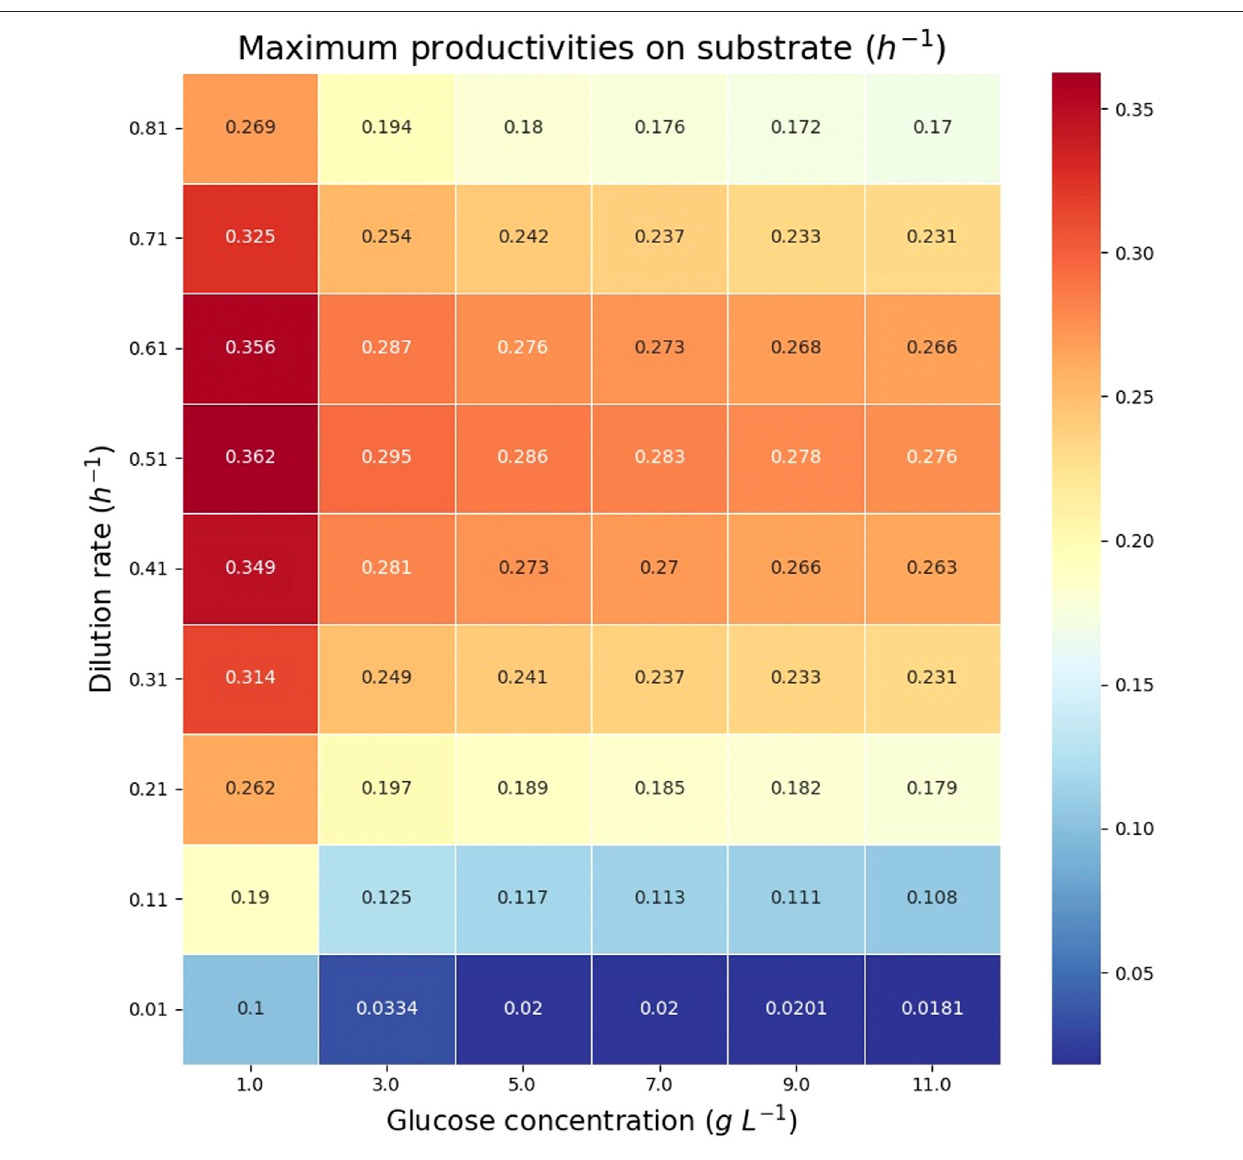
Frontiers in Molecular Biosciences |